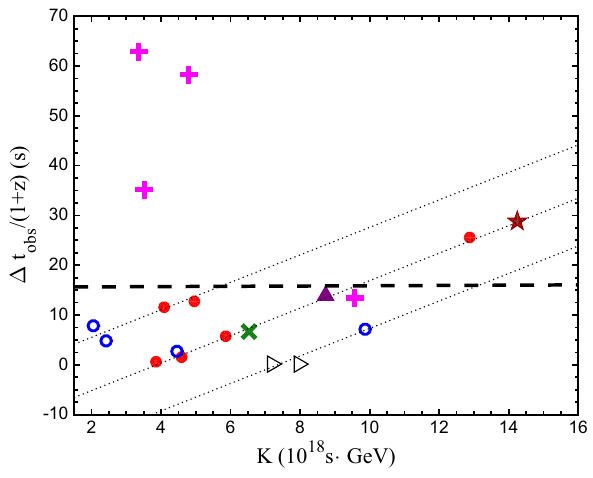
Fig. 13 The Δ t obs /( 1 + z ) – K plot for Band-Obs using Criterion 3. Two triangles refer to two events from short GRBs and the other points are events from long bursts. The dashed line marks the fit of all points, while the dotted lines were suggested in Refs.